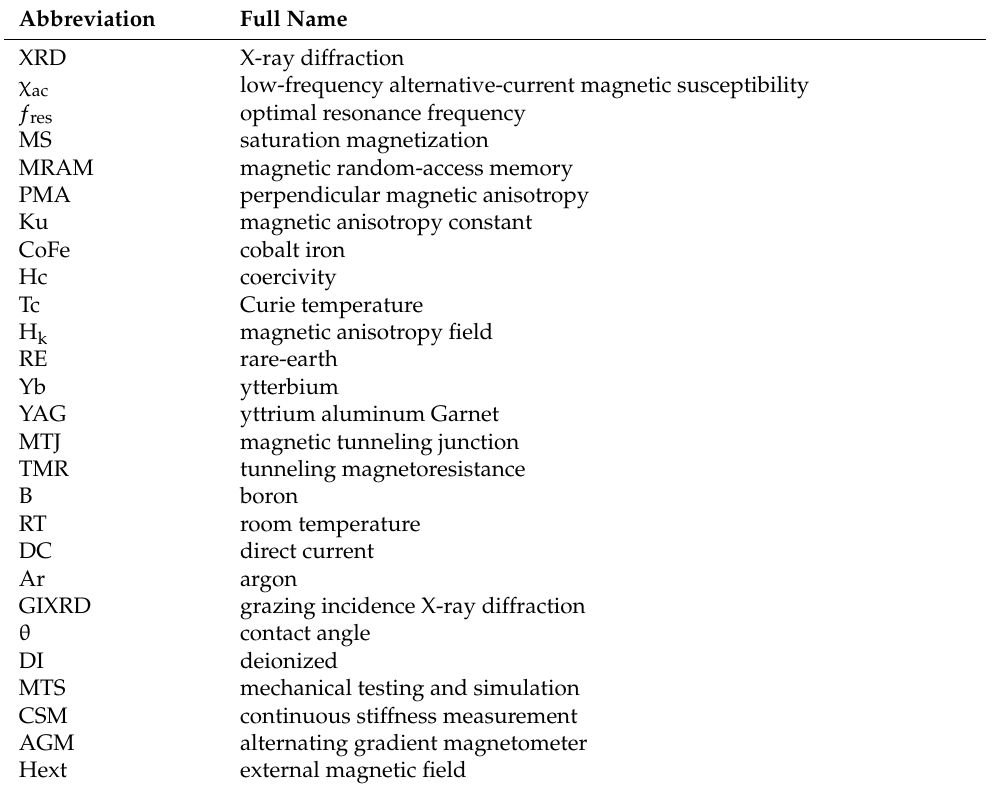
Table 1. Abbreviations and full names of proper